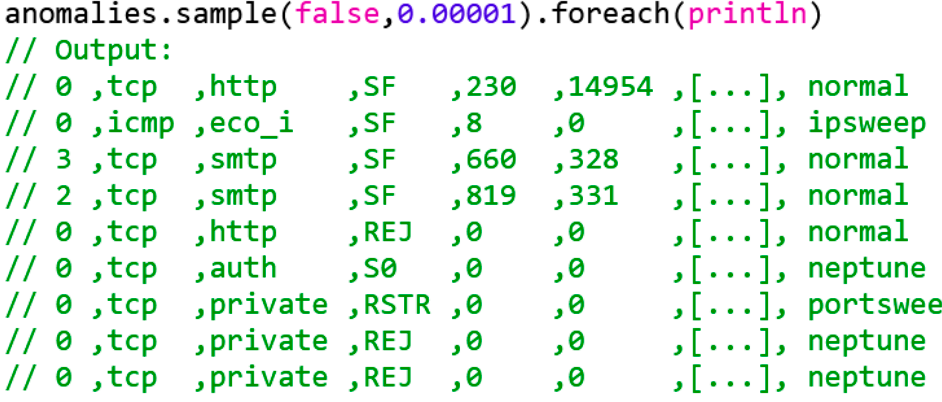
Figure 15. Extract of recognized anomalies with k = 100.